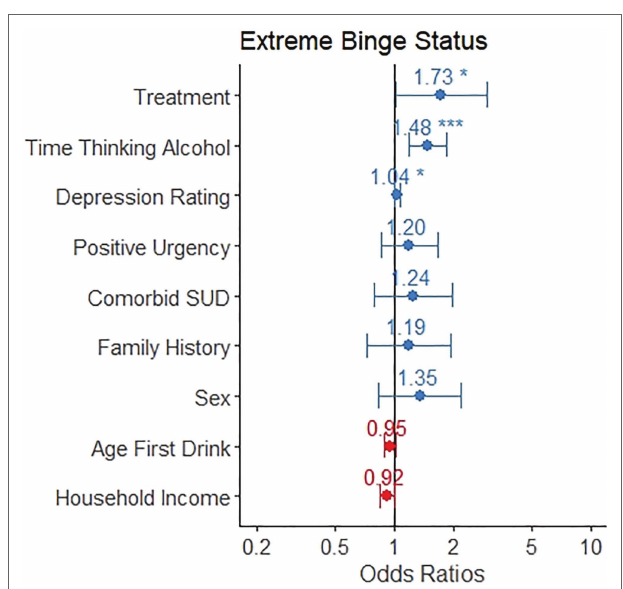
FIGURE 3 | The odds ratio for each variable as it relates to likelihood of any engagement of high-intensity binge drinking is depicted, along with a 95% confidence interval. Individuals in treatment, those who spent more time thinking about alcohol, and those with greater depression ratings were more likely to engage in high-intensity binge